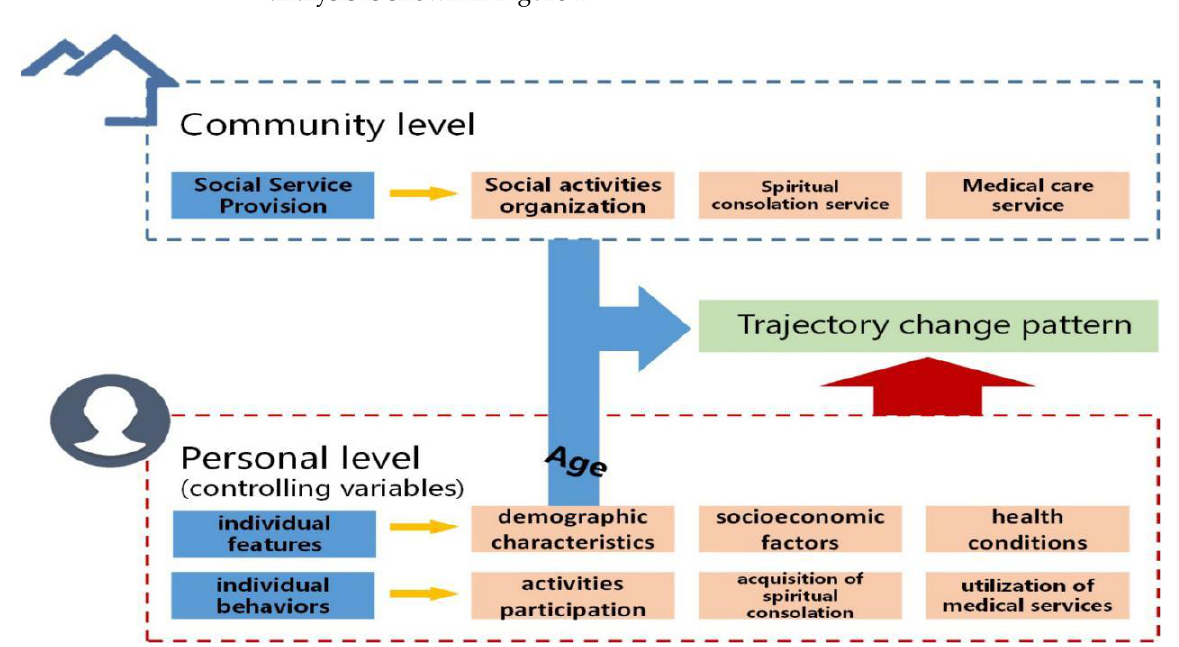
Figure 1. The frame diagram of the theoretical analysis.